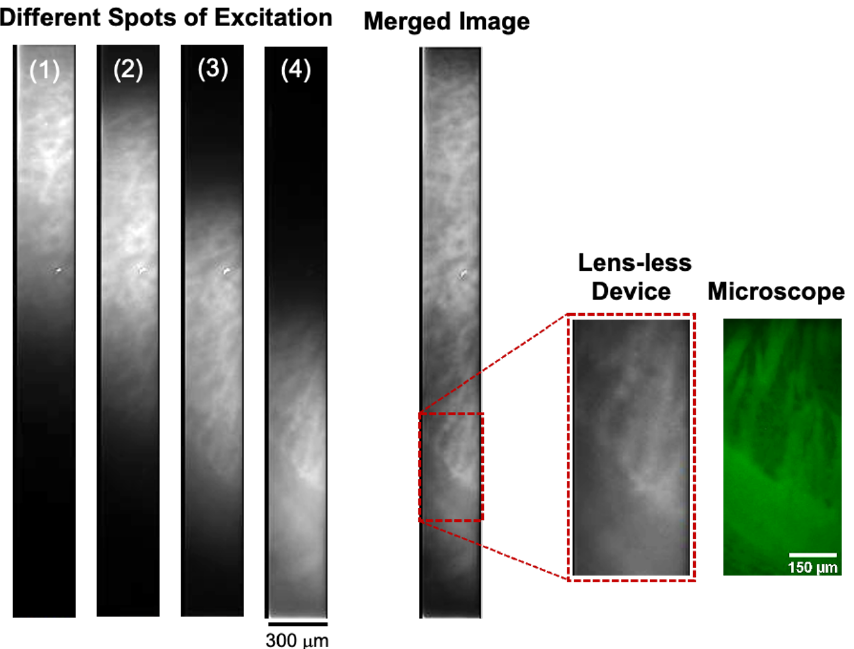
Figure 6. Fluorescent image from a brain slice captured by the needle sensor integrated with the hybrid filter. Owing to the narrow excitation light, four different irradiation spots (1–4) are required to excite all the sensor imaging areas. These images are merged for a large FOV by simple image processing. An ROI of the merged image, denoted by the dashed square, is enlarged and compared with the image obtained by the fluorescence